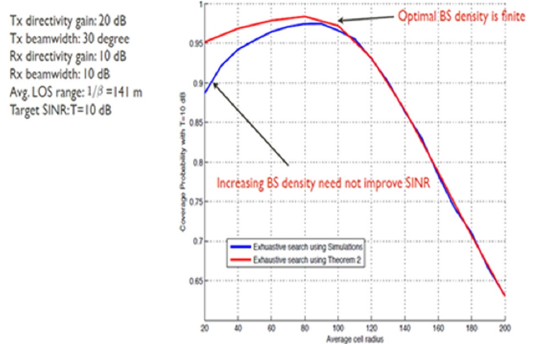
Figure 6. coverage probability on targeted SINR=10dB vs average cell radius